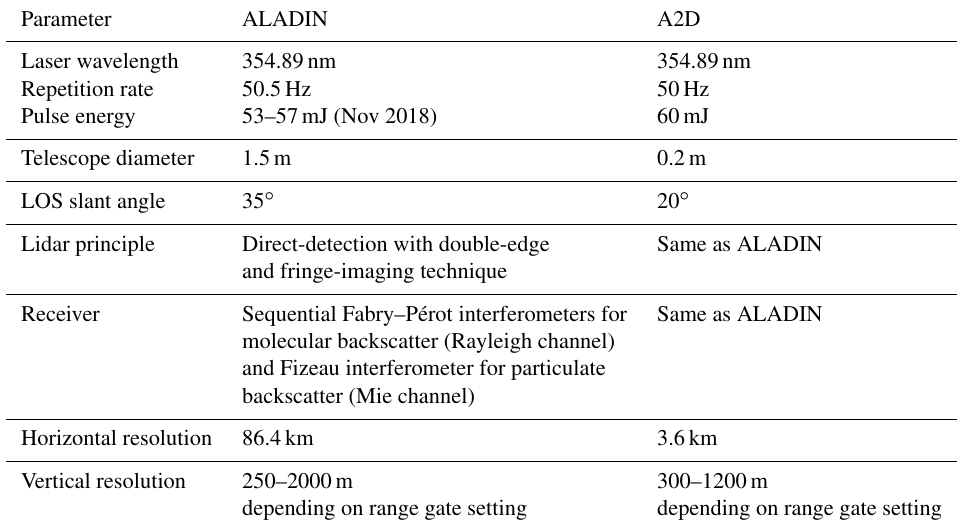
Table 1. Key instrument parameters of ALADIN and the A2D.